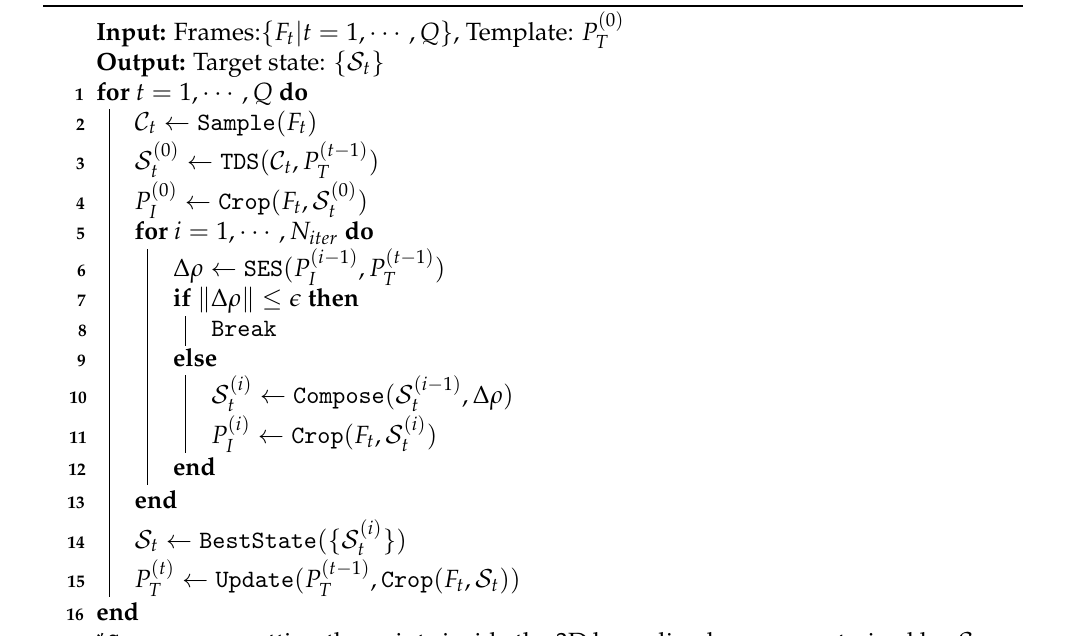
Algorithm 1: SETD online